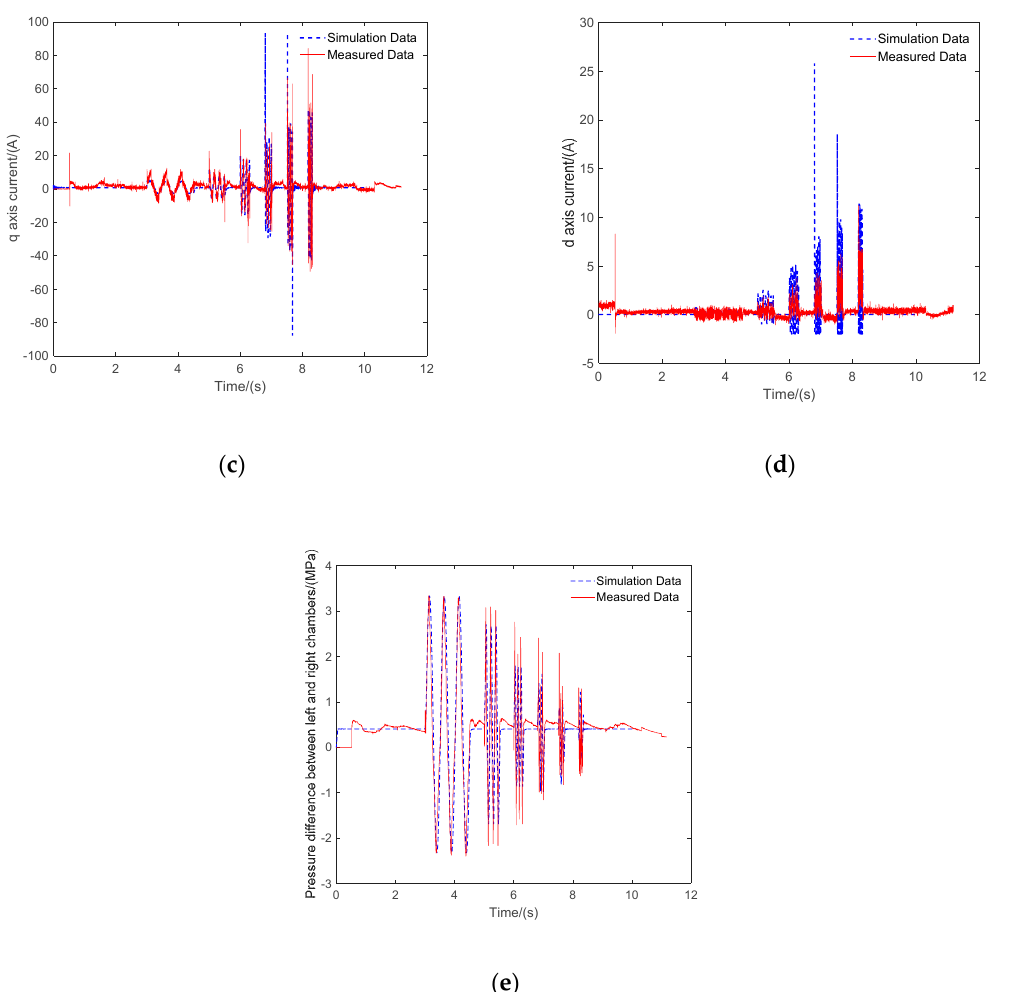
Figure 11. Comparison between simulation data and actual data of each variable of load 2.5-degree 1 Hz to 11 Hz command. ( a ) Angle comparison; ( b ) Motor speed comparison; ( c ) q axis current; ( d ) d axis current; ( e ) Pressure difference between the left and right chambers of the hydraulic cylinder.